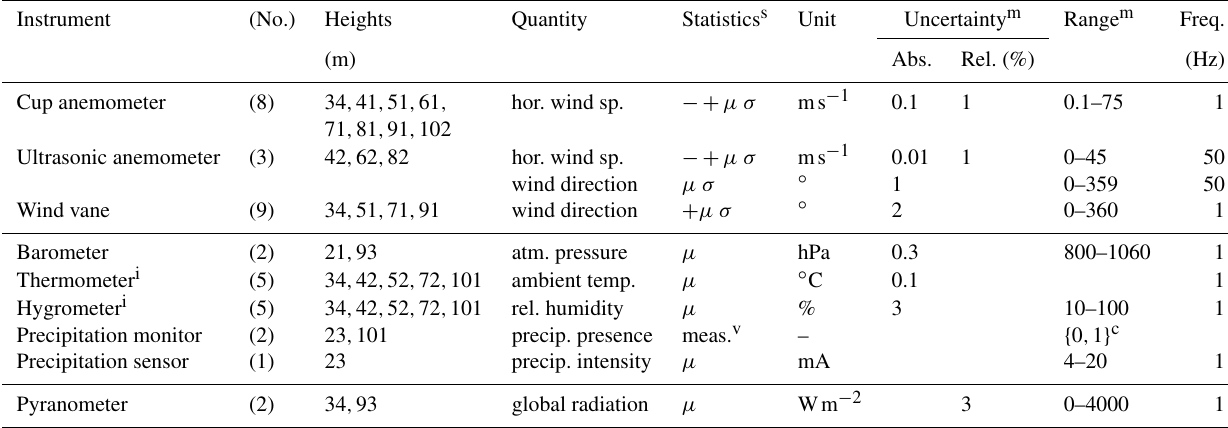
Table A2. An overview of the instruments and their locations on the FINO1 met mast (height in meters above the Lowest Astronomical Tide), the quantity measured, the measurement uncertainty, the measurement ranges, and the sampling frequencies. Instrument (No.) Heights